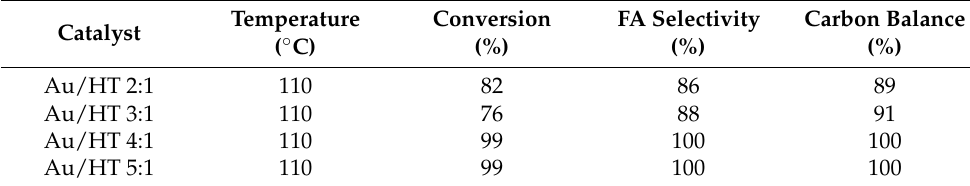
Table 1. Comparison of furfural oxidation efficiency for Au/HT catalysts with supports of different Mg: Al molar ratios. Reaction: p = 6 bar (O 2 ); t = 110 ◦ C; 2 h; 600 rpm; FF/Au molar ratio =